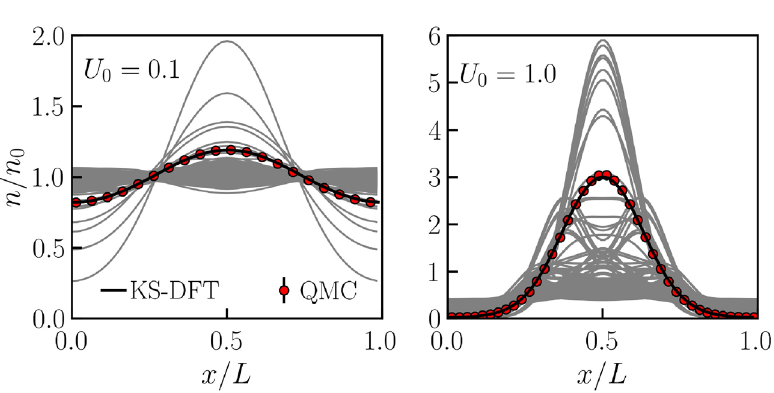
Figure 3. Analysis of the electronic structure for a weak ( U 0 = 0.1 ) and strong ( U 0 = 1.0 ) perturbation amplitude at a degeneracy parameter θ = 1.0 . The orbital density (solid grey) and the total density (solid black) distributions from KS-DFT calculations provide an explanation for the emergence of the collective modes and features illustrated in Fig. 2. For illustrative purposes, the orbital density is scaled by the number of